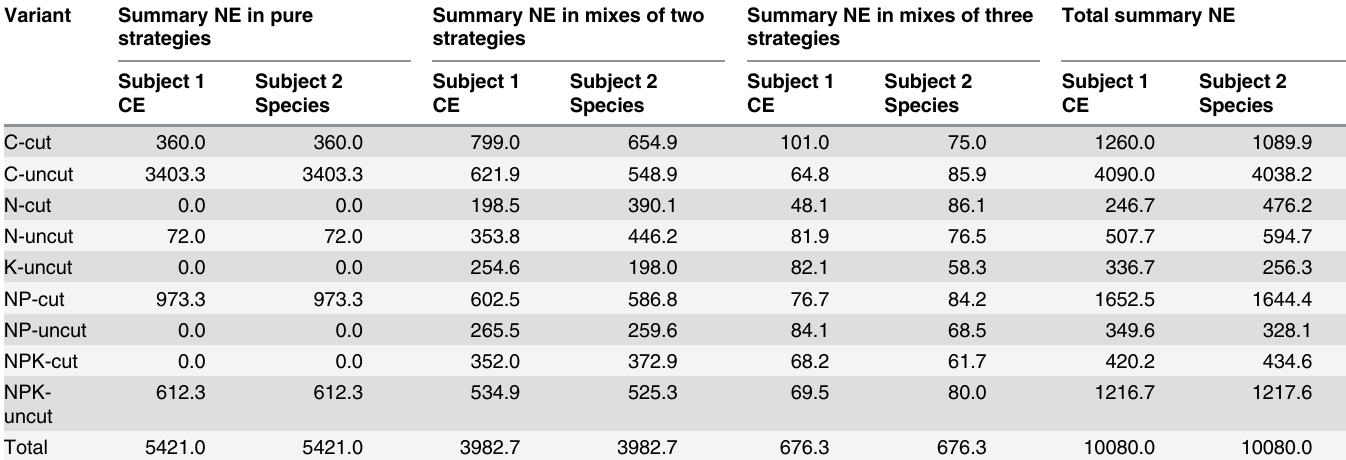
Table 1. Total Nash equilibrium (NE) found.